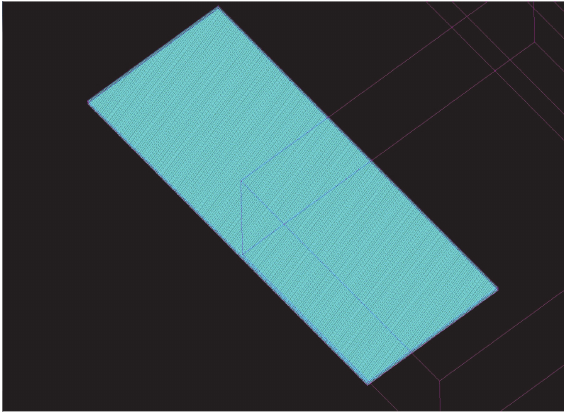
Figure 9. Extracted accessible positions in one